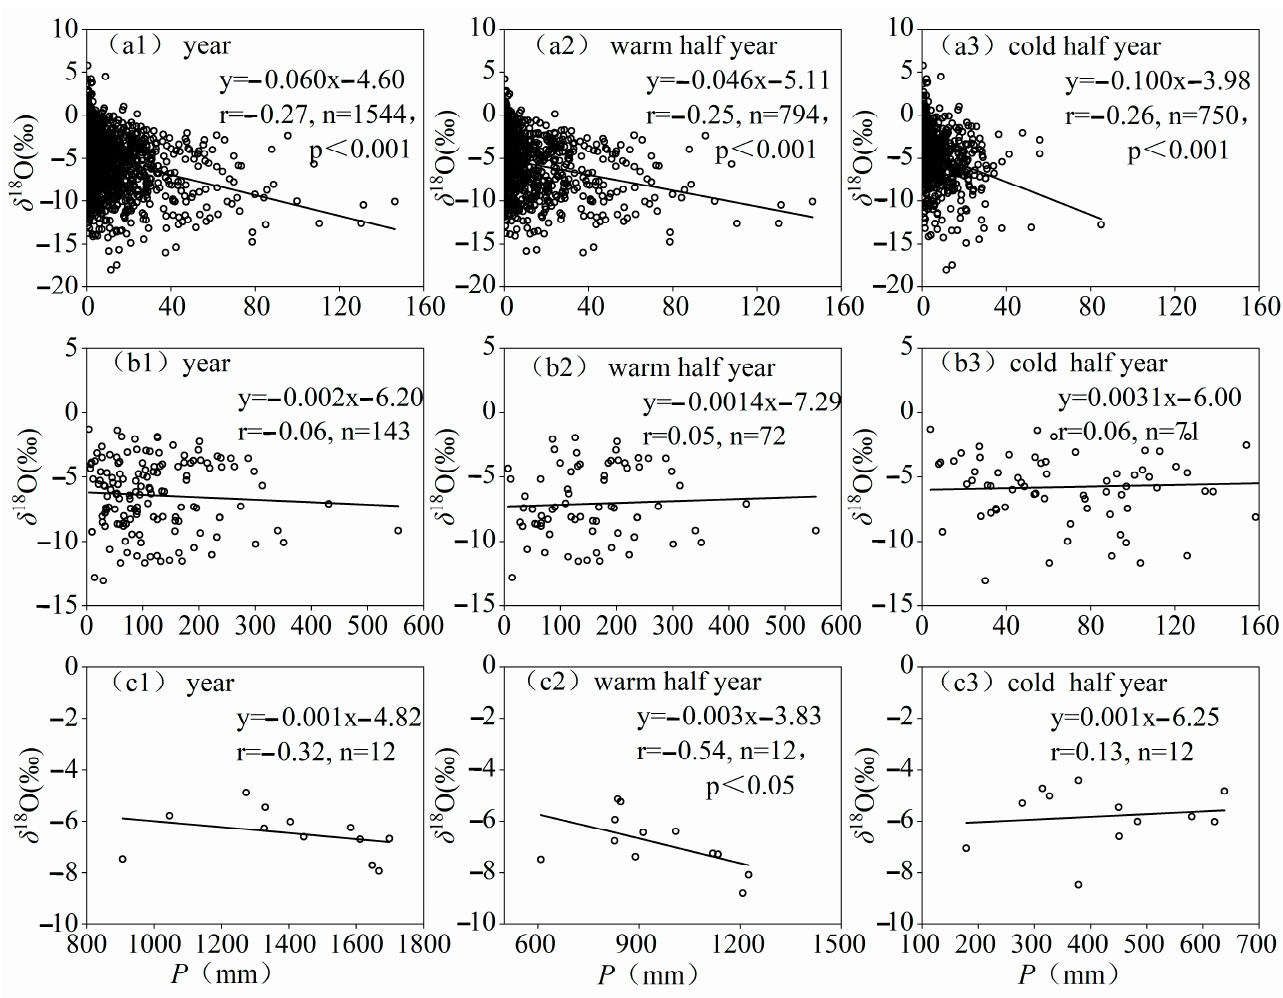
Figure 5. Correlated scatters of δ 18 O p versus precipitation ( P ) in Changsha on daily ( a1 , a2 , a3 ), monthly ( b1 , b2 , b3 ) and annual ( c1 , c2 , c3 ) time scales in three periods: entire year ( a1 , b1 , c1 ), warm half of the year ( a2 , b2 , c2 ) and cold half of the year ( a3 , b3 , c3 ) ( p > 0.05 is not marked in the